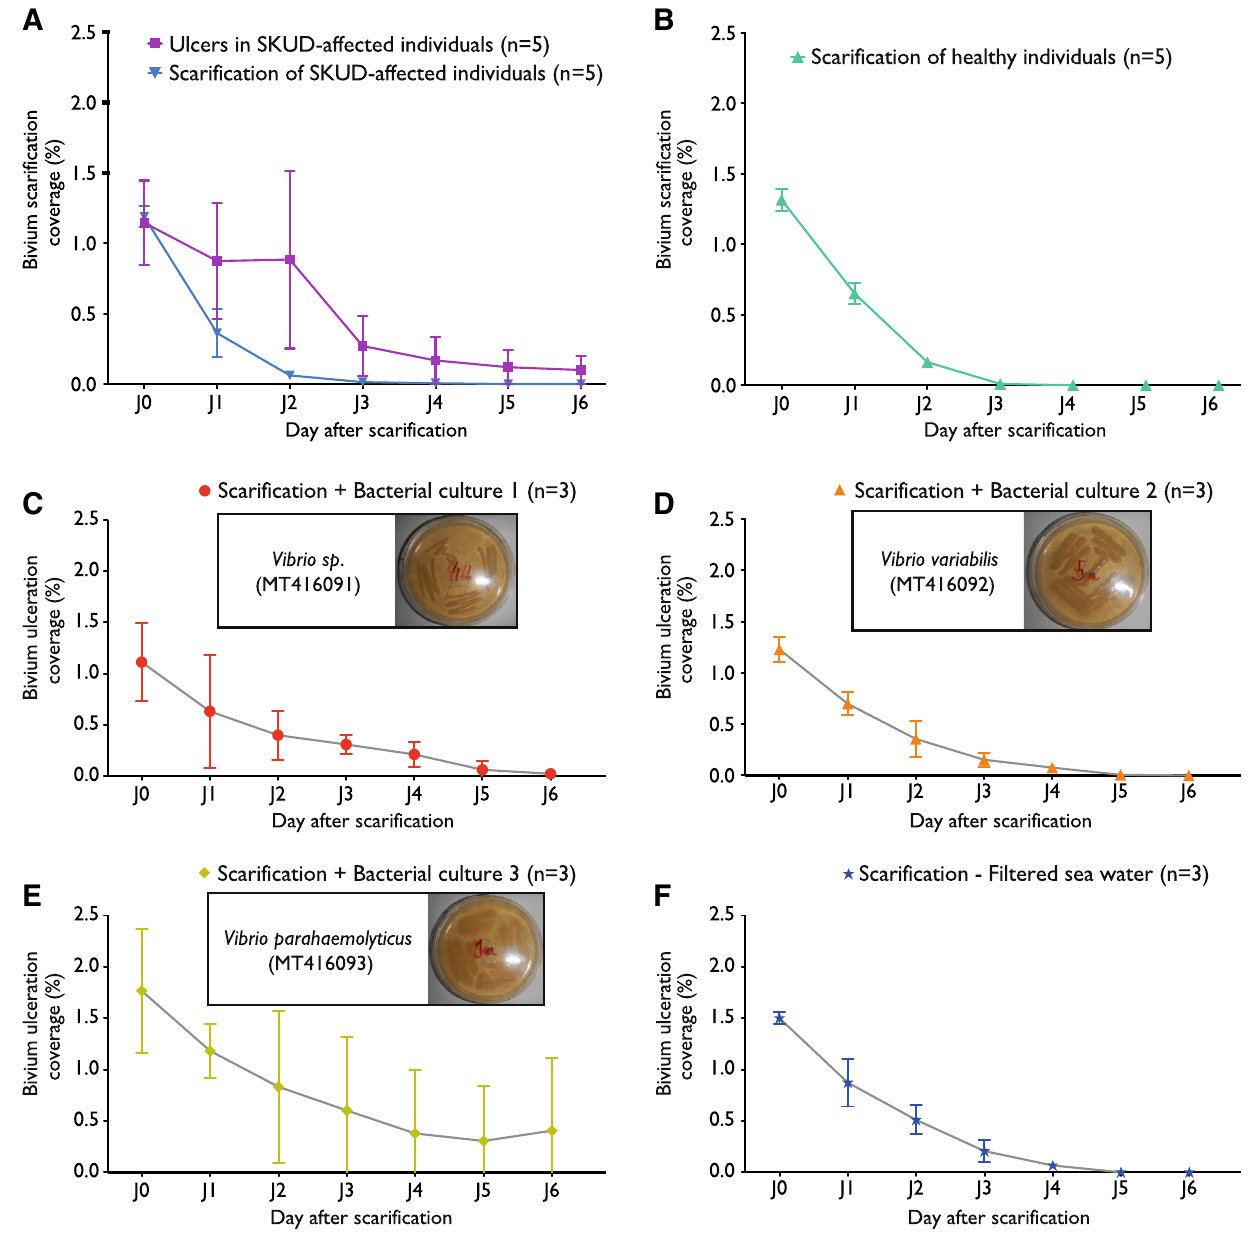
Figure 10. Attempted induction of SKUD in Holothuria scabra via the inoculation of cultured bacteria on the dorsal integument: three cultured bacteria, isolated from SKUD ulcers, were inoculated on artificial scarifications performed on the dorsal integument of the sea cucumbers. ( A ) Integument scarification/ulceration coverage observed for SKUD-ulcers (purple line) and artificial scarifications (blue line) in SKUD-affected sea cucumbers (controls). ( B ) Integument scarification/ulceration coverage observed in scarified healthy sea cucumbers (controls). ( C ) Integument scarification/ulceration coverage observed after inoculation of Vibrio sp. SKUD-MD-20 C1 (culture 1). ( D ) Integument scarification/ulceration coverage observed after inoculation of Vibrio variabilis SKUD-MD-20 C2 (culture 2). ( E ) Integument scarification/ulceration coverage observed after inoculation of Vibrio parahaemolyticus SKUD-MD-20 C3 (culture 3) ( F ) Integument scarification/ulceration coverage observed after inoculation of filtered sea-water (negative the ulceration surface was reduced to almost zero for Vibrio sp. and V. variabilis inoculation treatments (as well as for the controls) indicating that the natural recovery was apparently not affected. A higher variability was observed for individuals inoculated with Vibrio parahaemolyticus but the same general tendency is observed. The three individuals inoculated with Vibrio sp. SKUD-MD-20 C1 (culture 1) saw new lesions that appeared at the level of the mouth or the cloaca. However, only one individual still had these lesions on the last day of the experiment. Yet, the three individuals inoculated with Vibrio variabilis SKUD-MD-20 C2 showed, in the end,